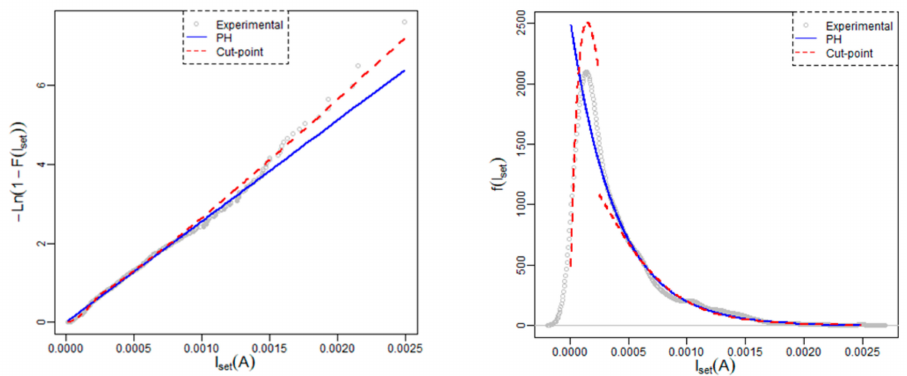
Figure 7. Cumulative hazard rate ( left ) and probability density function ( right ) for 1000 set current and the corresponding PH and cut-point PH